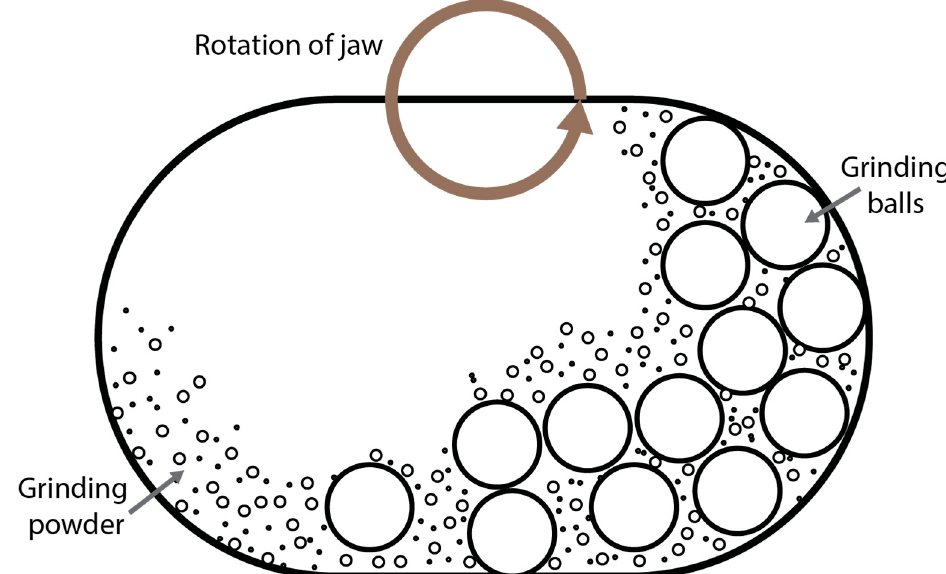
Figure 1. Schematic view of the motion of the balls and powder in a jar during high energy ball